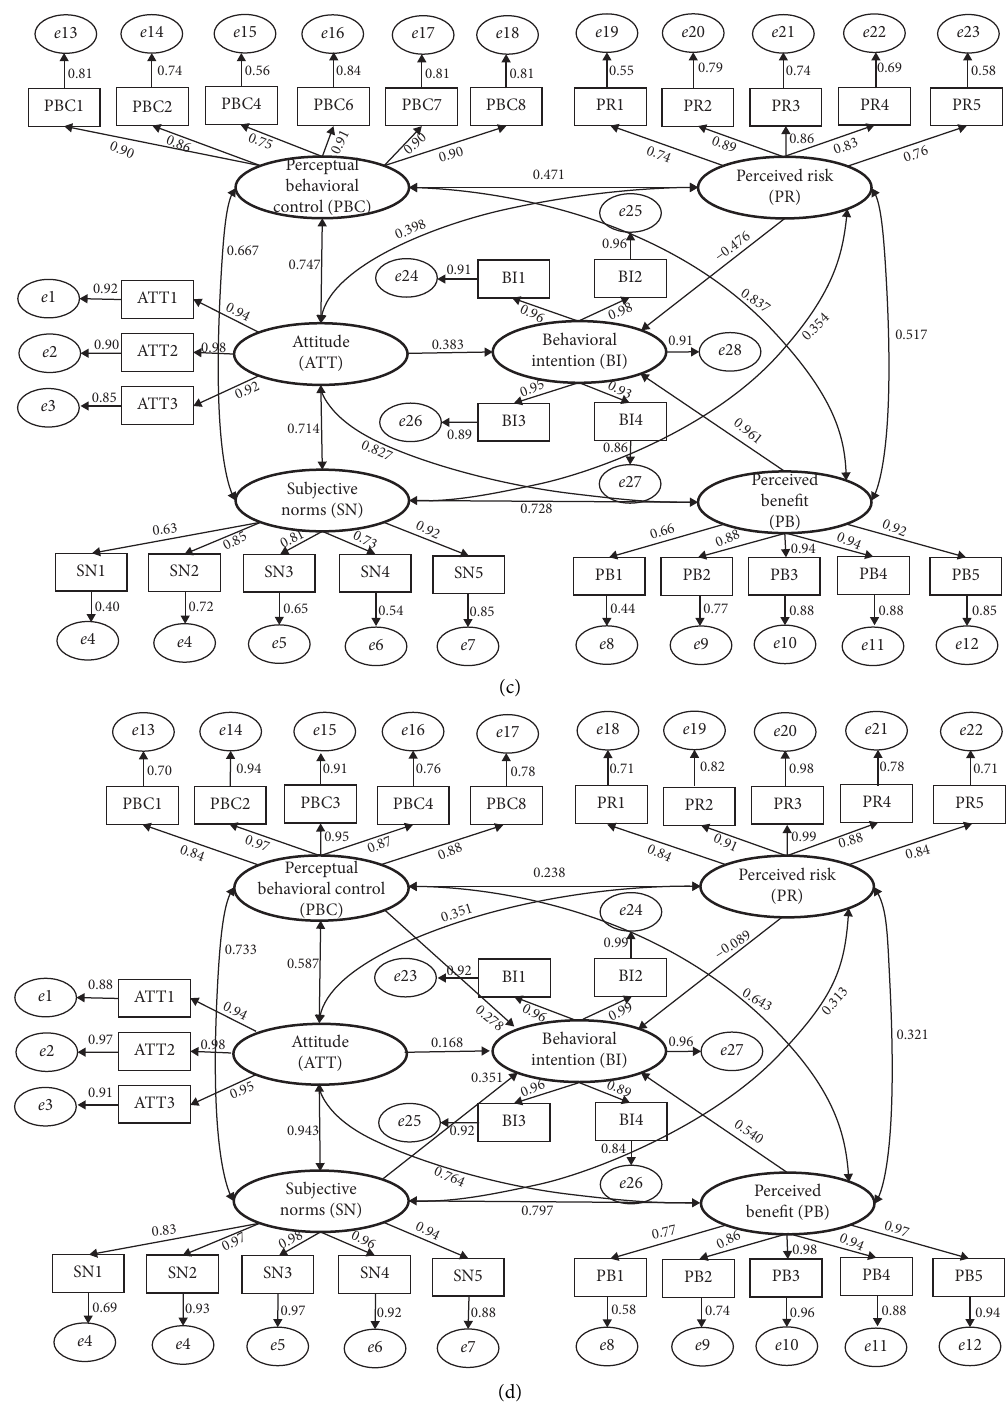
Figure 5: (a) Modified results of the optimized model for first-tier cities. (b) Modified results of the optimized model for second-tier cities. (c) Modified results of the optimized model for third-tier cities. (d) Modified results of the optimized model for fourth-tier